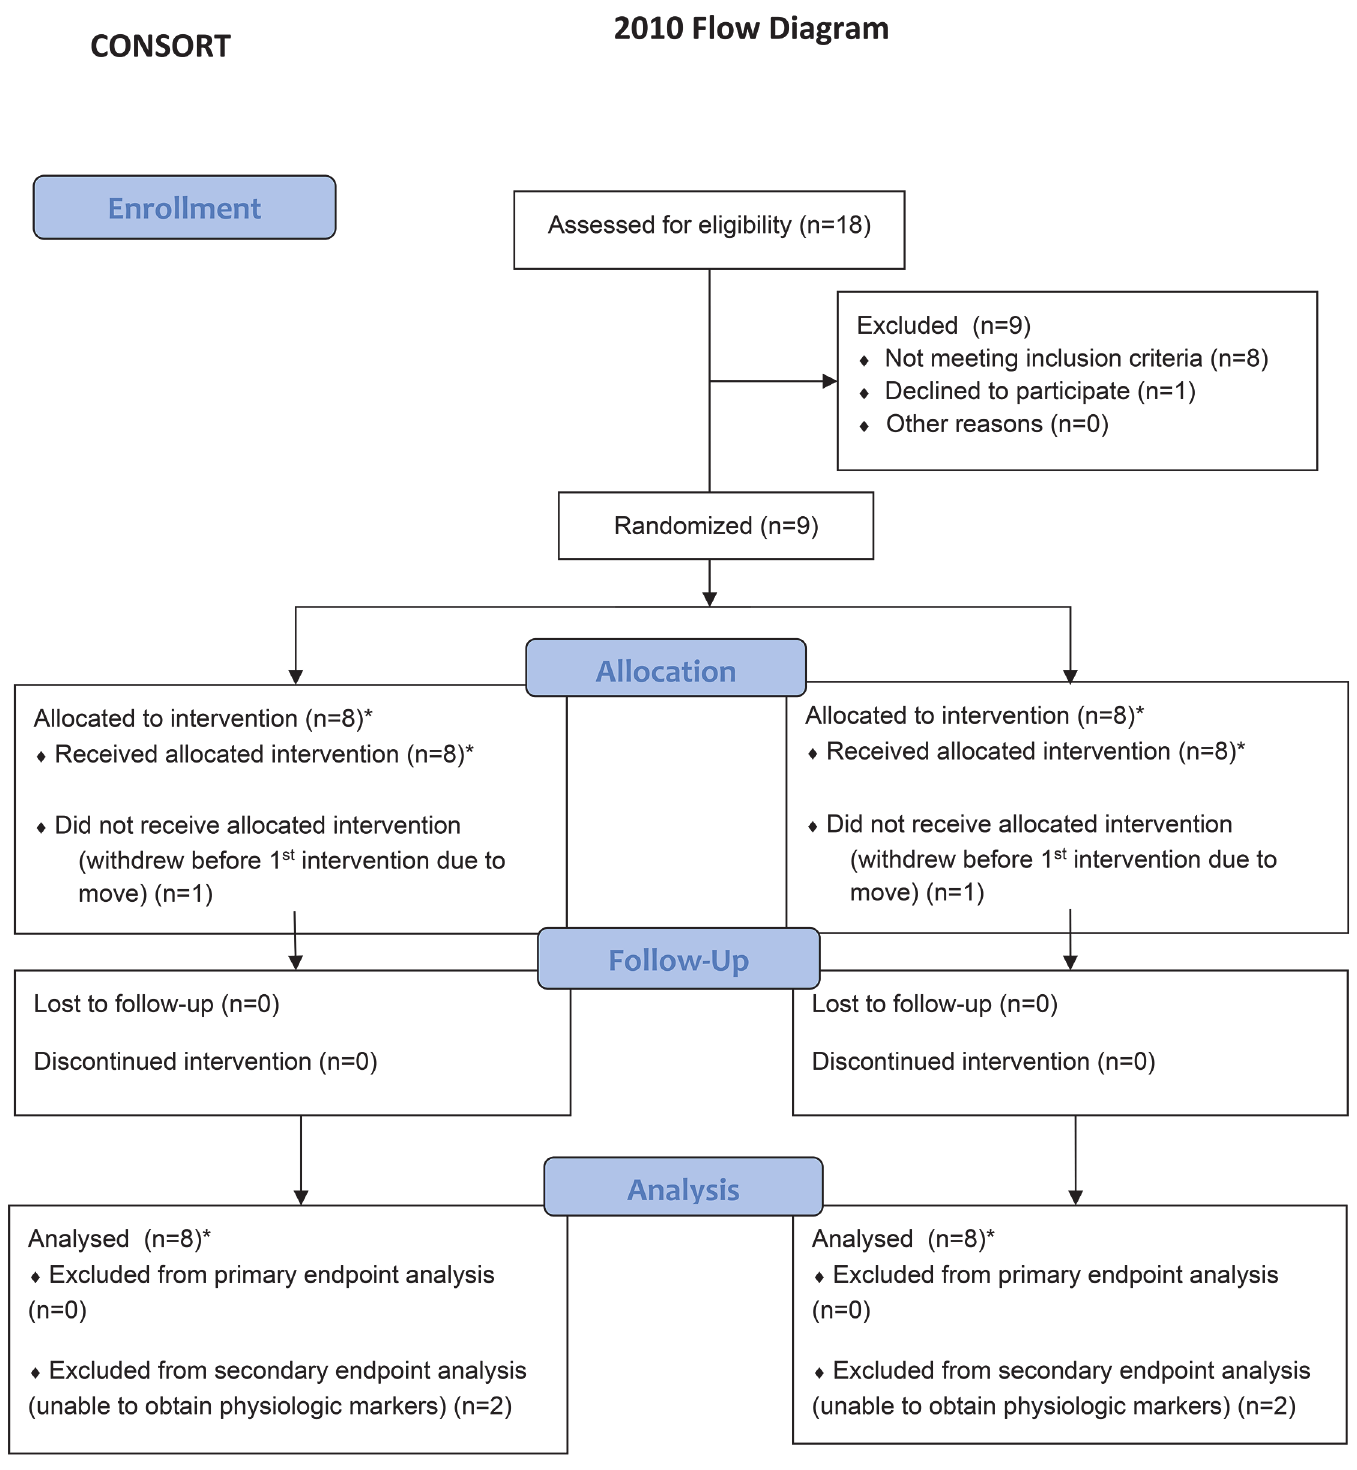
Fig 1. Consort diagram. * Prior to enrolment, a randomization schedule was created by random sorting of the five rTMS sites for each subject. All 8 subjects each received rTMS to five separate sites including sham over the course of the trial. (See Table 2 for the randomized order of interventions by subjects).